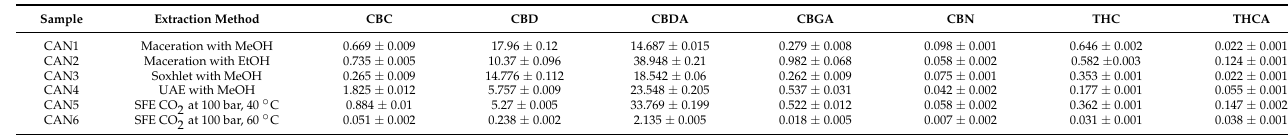
Table 3. Phytocannabinoids in Cannabis sativa extracts dissolved in DMSO and analysed by LC-MS/MS. Data are expressed as mg/g (mean, n = 3 ± SD).